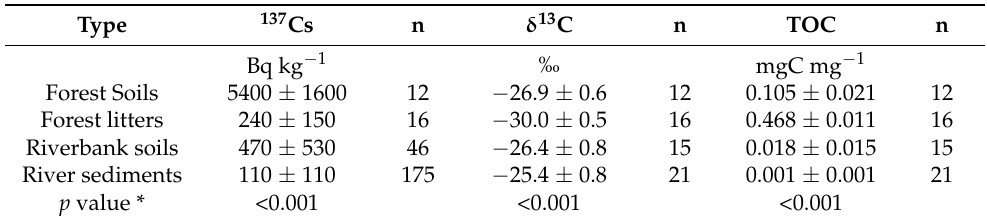
Table 2. 137 Cs and δ 13 C values for four potential SS sources. Averages are shown with the standard deviations (S.D.) in